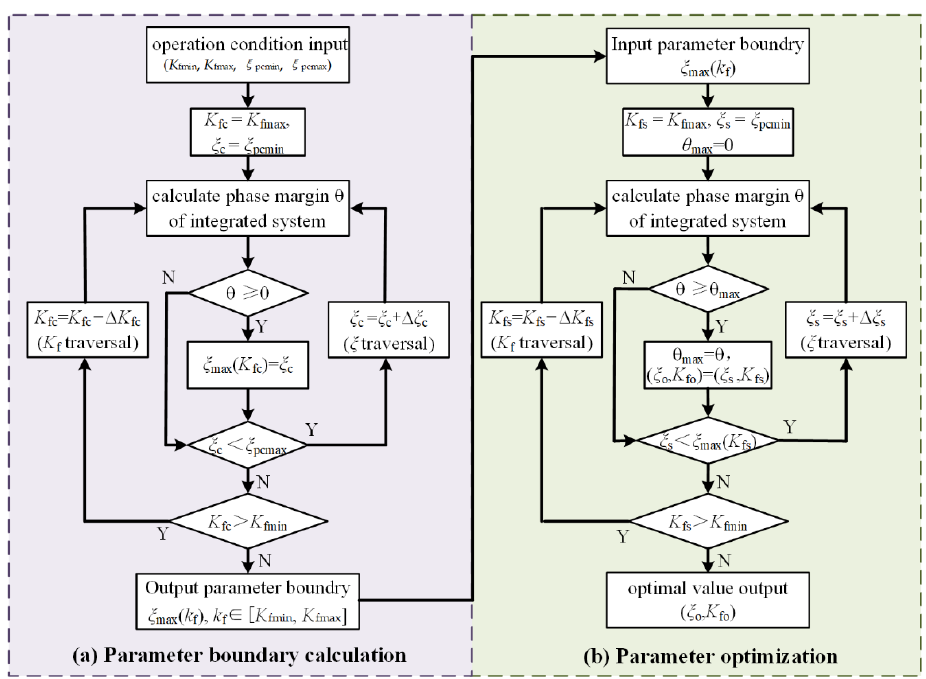
Figure 11. The flow chart of the impedance optimization ( a ) the calculation process of parameter boundary; ( b ) the process of parameter optimization.